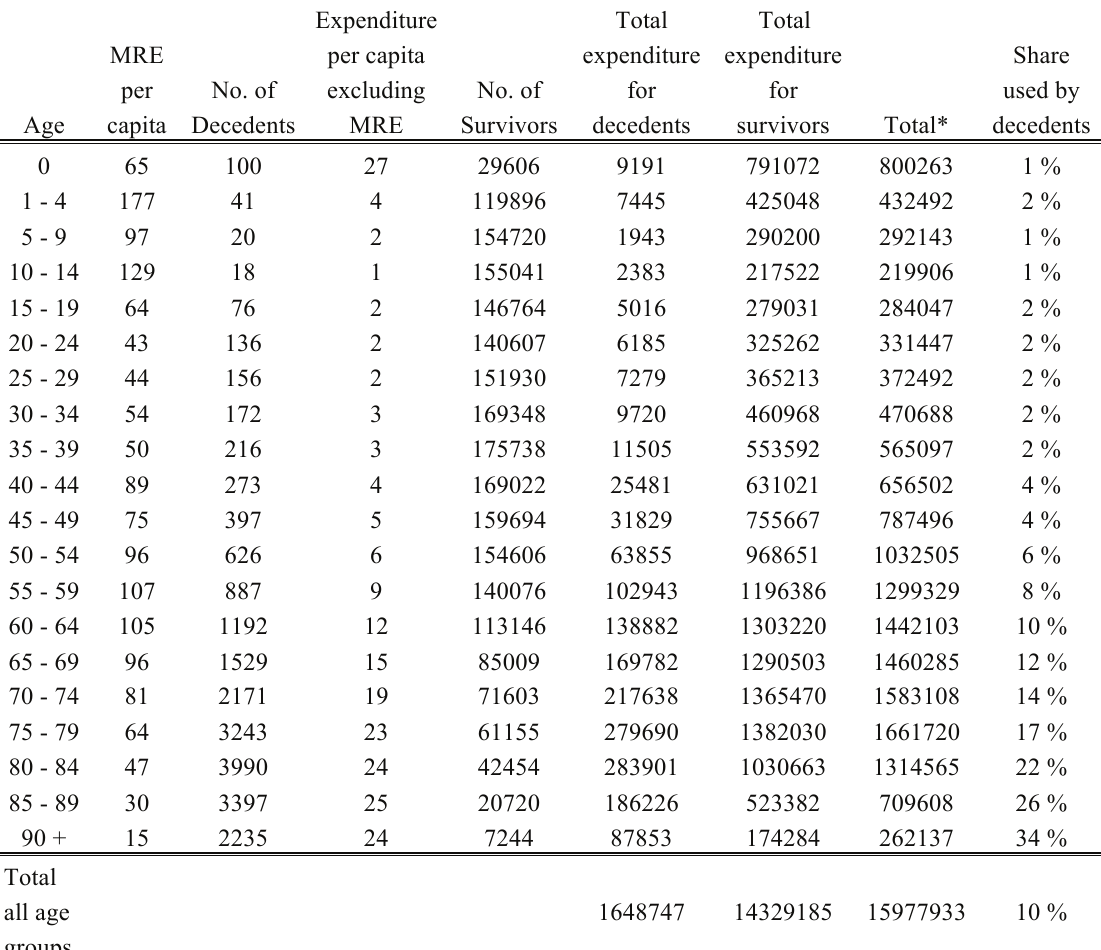
Table 4a: Estimated expenditures in 1000 NOK for males per year